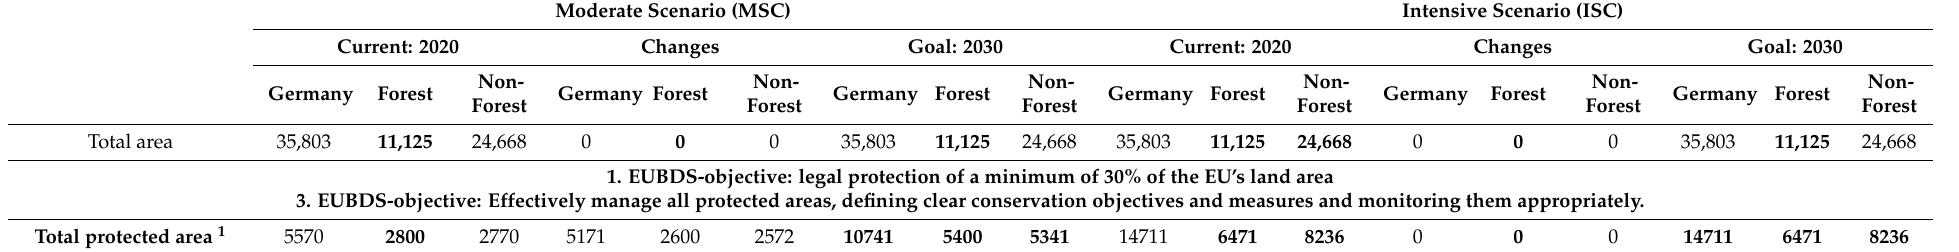
Table A4. Area balance sheet of land use categories in Germany in 2020 and 2030 according to the goals of the MSC and ISC in 1000 ha [authors’ results]. Moderate Scenario